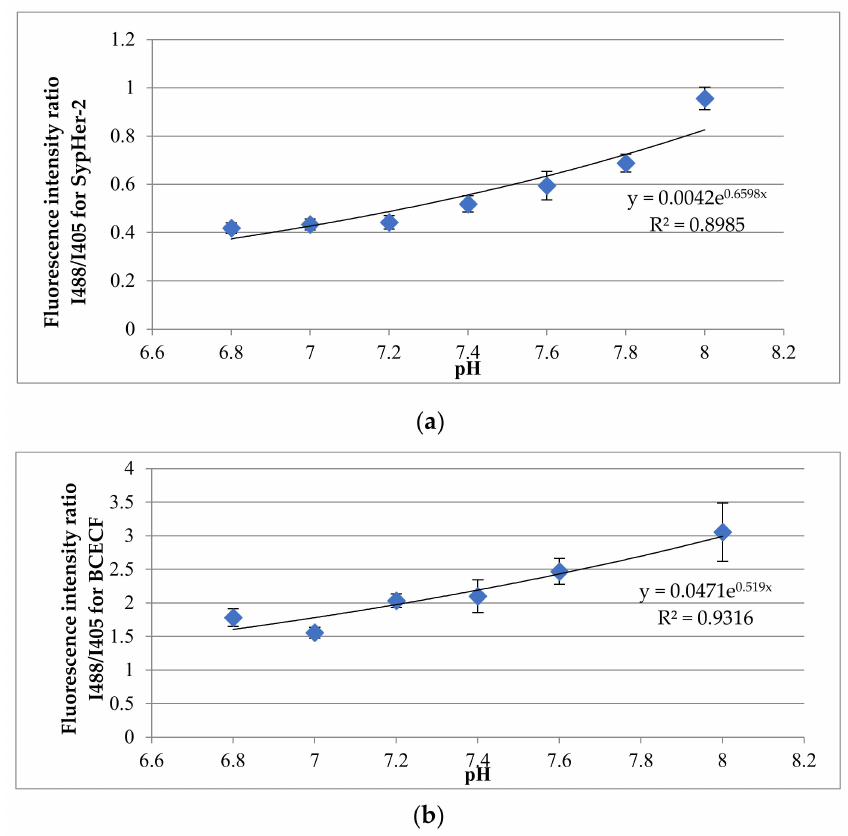
Figure 9. Analysis of the intracellular pH in iDP and hDP spheroids. ( a ) Calibration curve of the dependence of the ratio of fluorescence intensities on the pH for SypHer-2 in iDP spheroids (mean ± SD); ( b ) calibration curve of the dependence of the ratio of fluorescence intensities on the pH for BCECF in hDP spheroids (mean ±